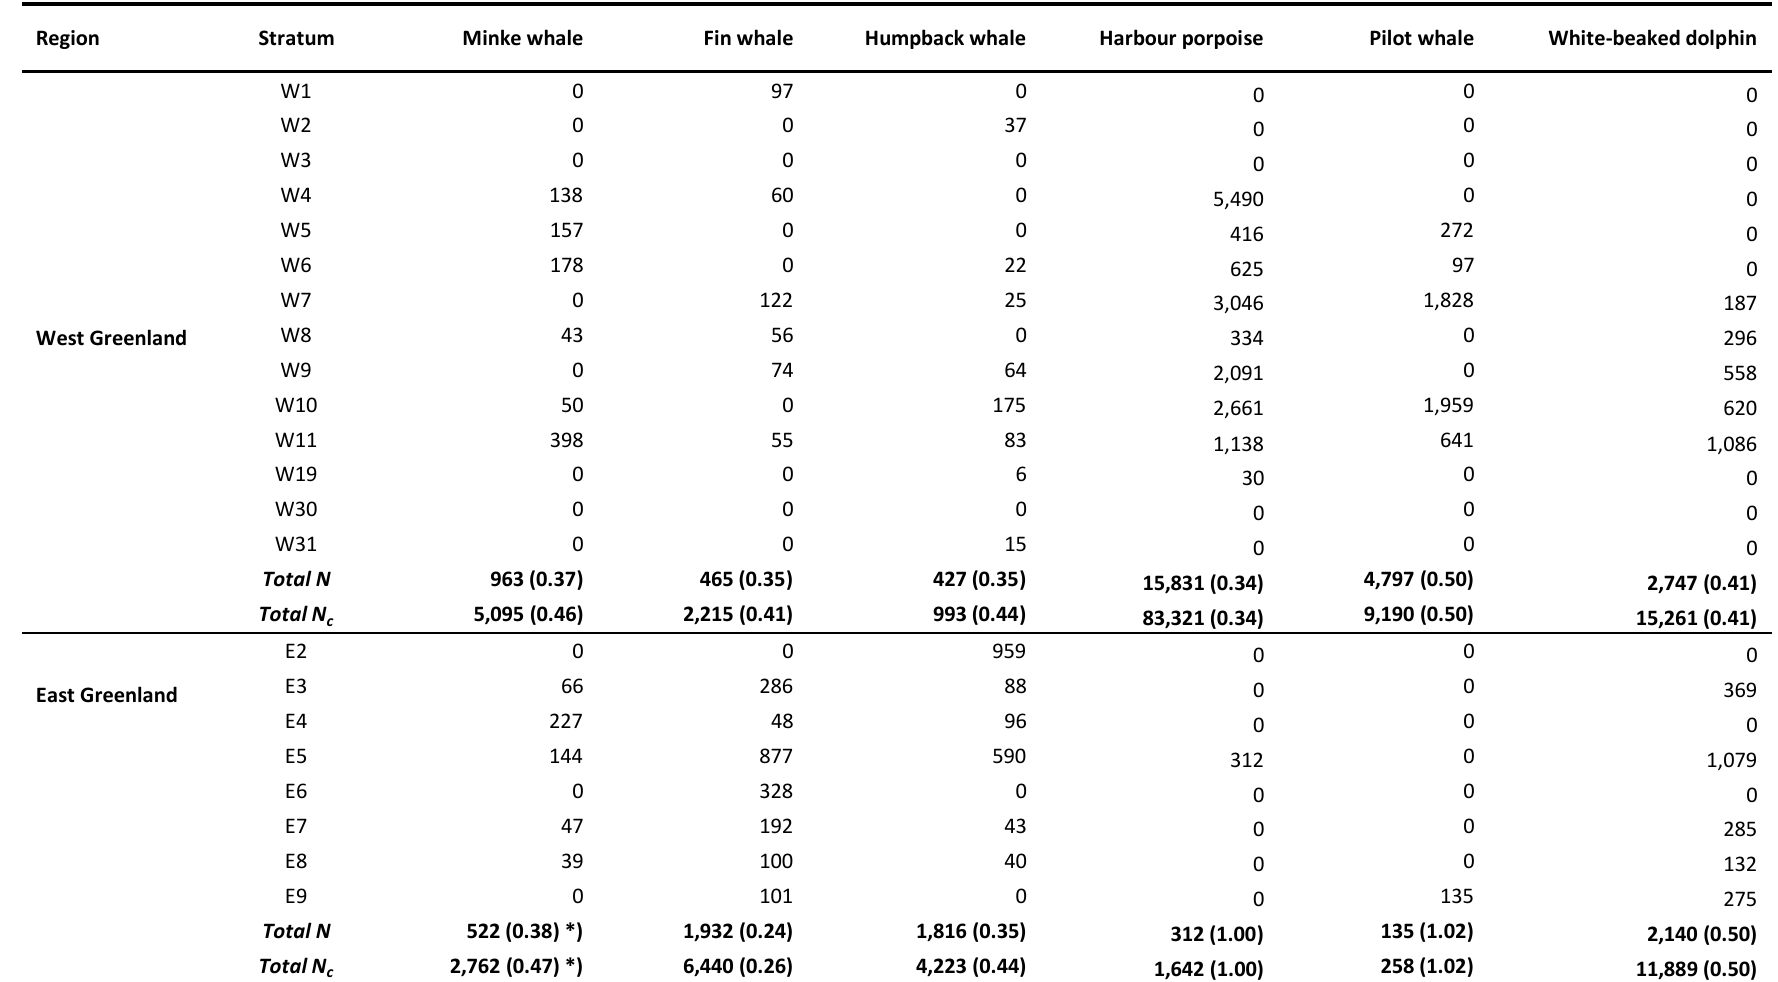
Table 6. Abundance ( N ) per strata of minke whales at ss <3 (23 sightings), abundance of fin whales at ss <5 (75 sightings), humpback whales at ss <5 (76 sightings), harbour porpoise at ss <3 (76 sightings), pilot whales at ss <5 (42 sightings) and white-beaked dolphins at ss <5 (48 sightings) in 2015 by stratum in West and East Greenland estimated by MRDS analysis, except for minke whales in West Greenland that are estimated by a